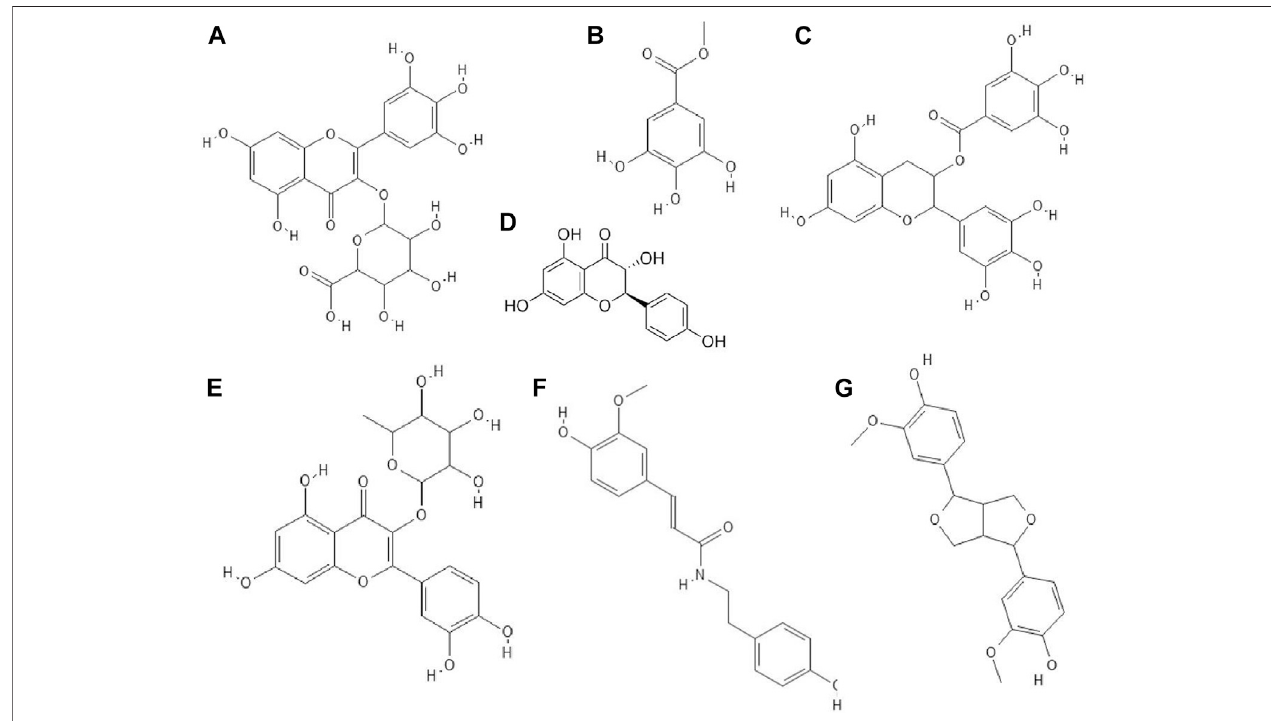
FIGURE5| Thestructuresof:myricetin-3-O-glucuronide (A) ,methylgallate (B) ,epigallocatechingallate (C) ,dihydrokaempferol (D) ,quercitrin (E) ,N-trans-ferulolyl tyramine (F) , pinoresinol (G) . 32 – 38,44 (the chemical structures of A, B, C, E, F, G are available at https://pubchem.ncbi.nlm.nih.gov/, National Center for Biotechnology Information, 2021, and the structure of D is available at Sigma-Aldrich